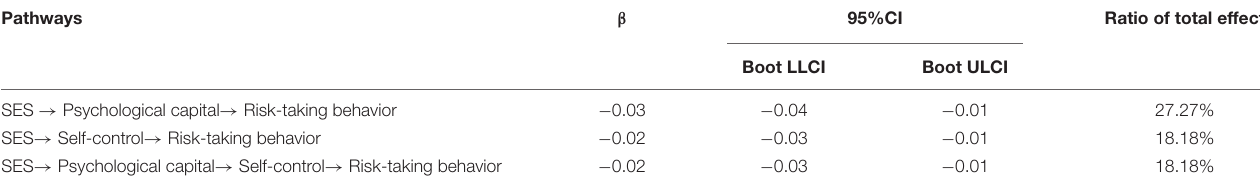
TABLE 2 | The mediating effects of psychological capital and self-control.